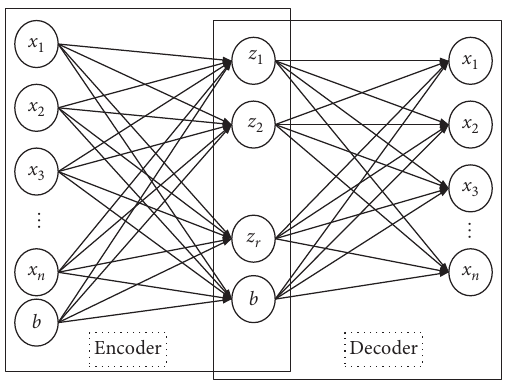
Figure 1: The network structure of